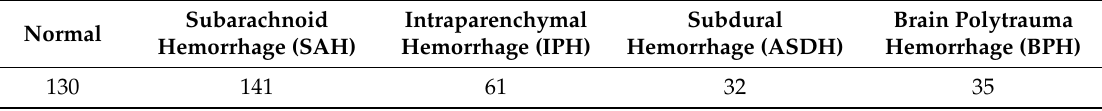
Table 1. Number of original unique patient computed tomography (CT) scans.